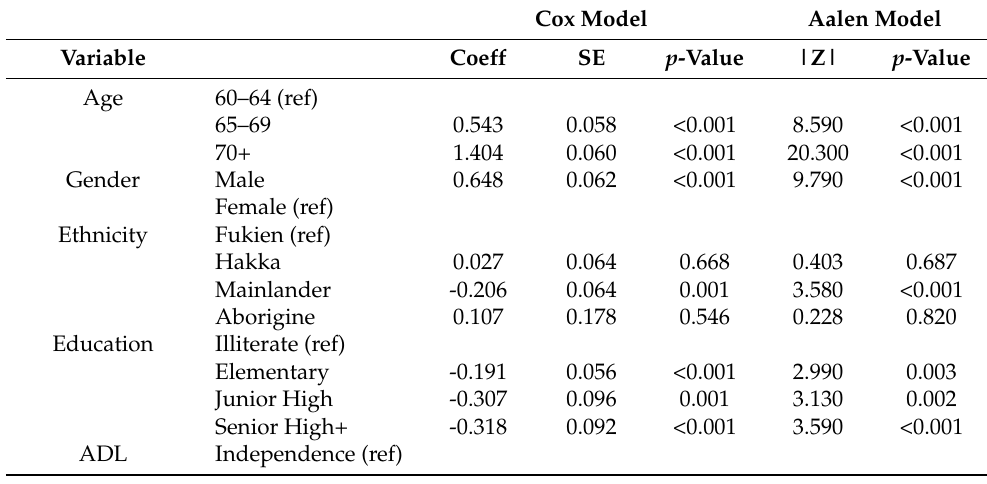
Table 5. Results of Model 6 by the Cox frailty model and Aalen’s frailty time-dependent model.